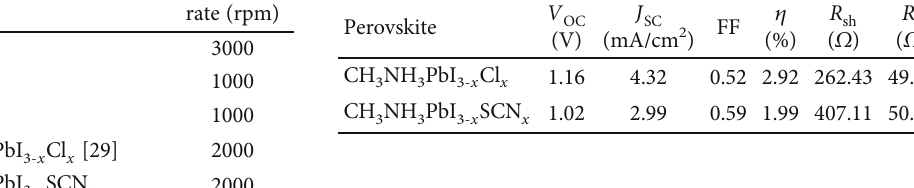
Table 1: Optimized spin coating rate of each layer. Layer